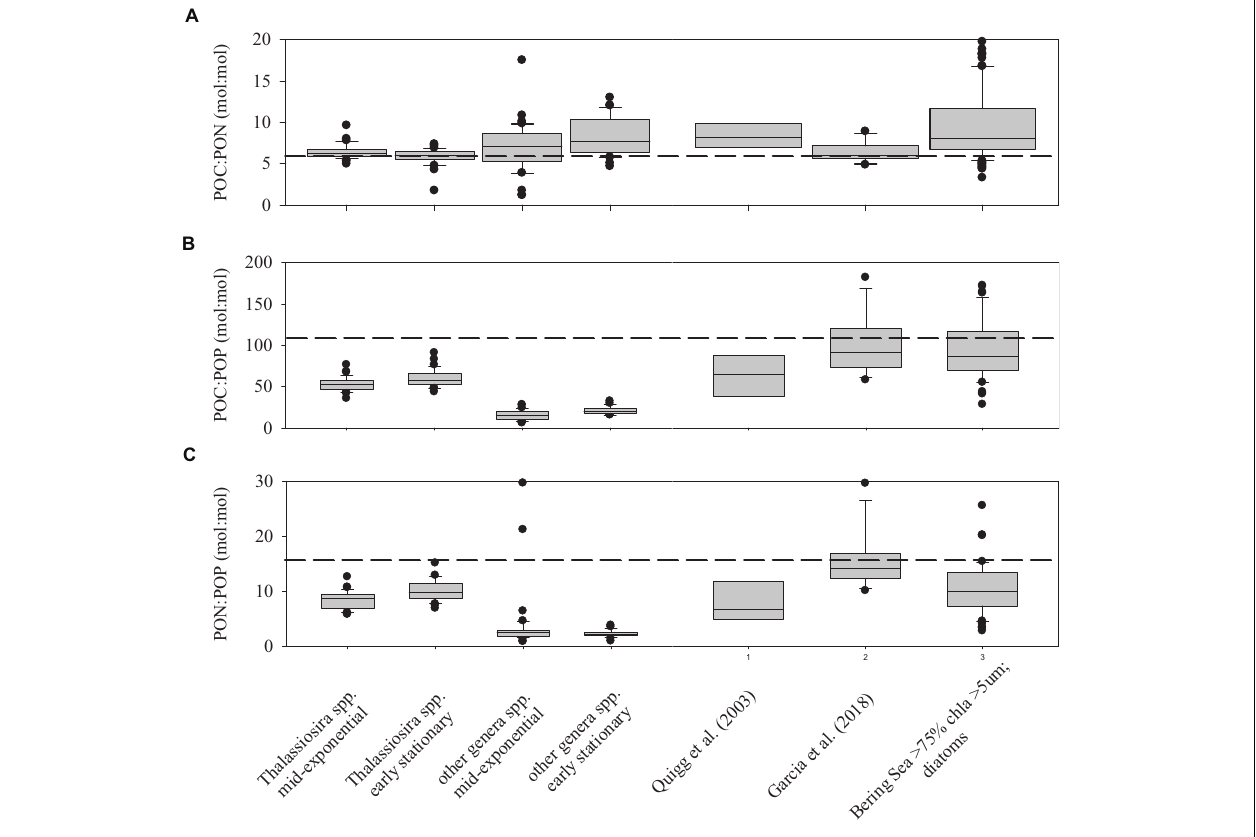
FIGURE 4 | Box-Whisker plots of the ratios of POC:PON (A) , POC:POP (B) , and PON:POP (C) for cultures of the genus Thalassiosira and the other cultures studied in both exponential and stationary growth. For comparison, the data for diatom cultures presented in Quigg et al. (2003) and Garcia et al. (2018) are plotted, and data from the Bering Sea Shelf where diatoms dominated ( > 75%) of the total chlorophyll a (Lomas, unpublished data).